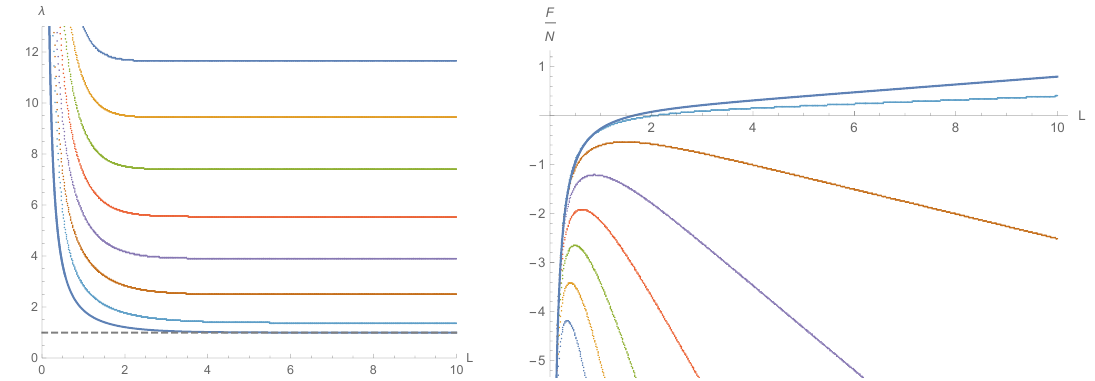
Figure 2 . Left panel: VEV of (cid:21) as a function of L , with (cid:3) = 1 and T = 0 ; 0 : 5 ; 1 ; : : : ; 3 : 5, respectively, from the bottom to the top. Right panel: the free energy for the same values and M = 0 as functions of L . In the right panel the curves refer to the temperatures T = 0 ; 0 : 5 ; 1 ; : : : ; 3 : 5, from the top to the